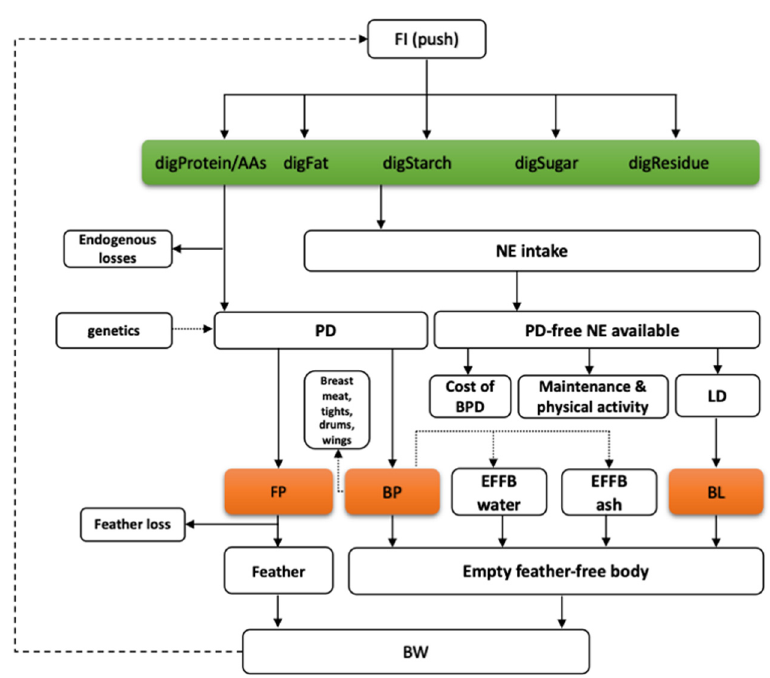
Figure 1. The flowchart of the nutrient partitioning model for digestible nutrients, including protein (amino acids, digProt, and digAAs), starch (digStarch), sugars (digSugar), lipids (digFat), and residue (digResidue); where: FI—feed intake, NE intake—net energy intake, PD—protein deposition, PD-free NE—protein deposition free net energy, LD—lipid deposition, FP—feather protein, BP—empty feather-free body protein, BL—empty feather-free body lipid, EFFB water—empty feather-free body water, EFFB ash—empty feather-free body ash, BW—body weight [6].